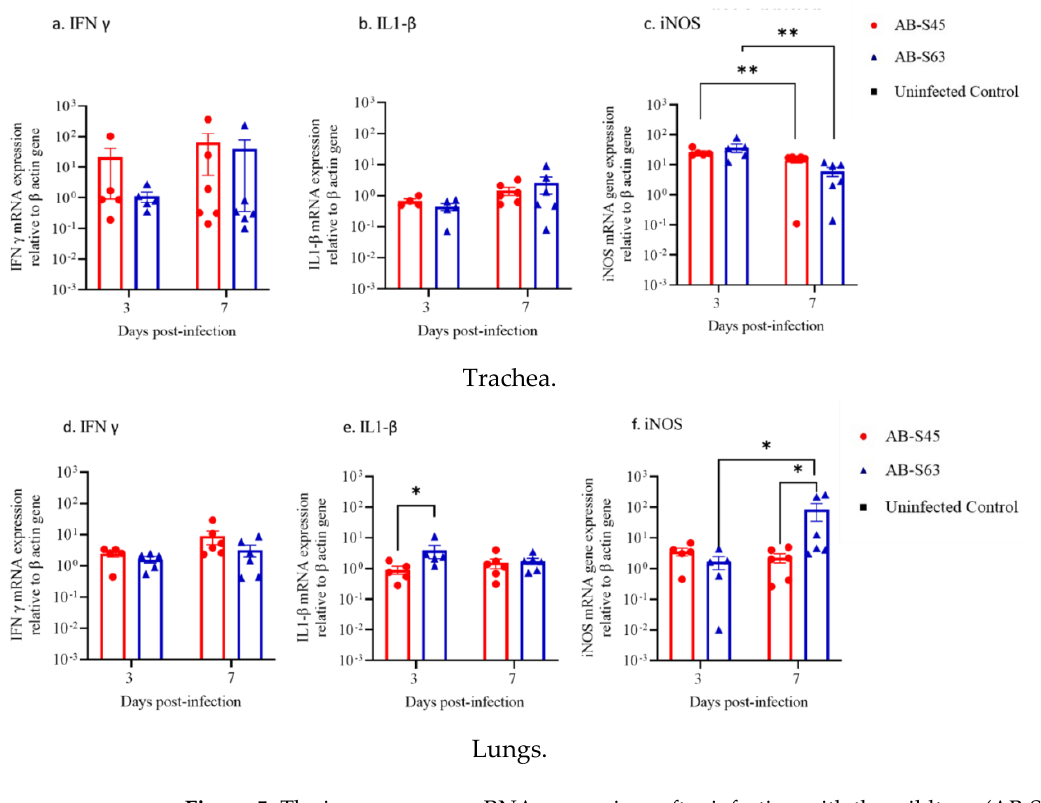
Figure 5. The immune gene mRNA expressions after infection with the wildtype (AB-S63) and CEO vaccine revertant (AB-S45) ILTV isolates. IFN- γ, IL - 1β , and iNOS mRNA expressions in the trachea at 3 and 7 dpi is shown in ( a , b , c ), respectively, and in the lungs at 3 and 7 dpi are illustrated in ( d , e , f ), respectively. The Mann–Whitney U test was used to analyze the differences between time points and between groups. The error bars represent the SEM. Significance: * p < 0.05, ** p < 0.01.